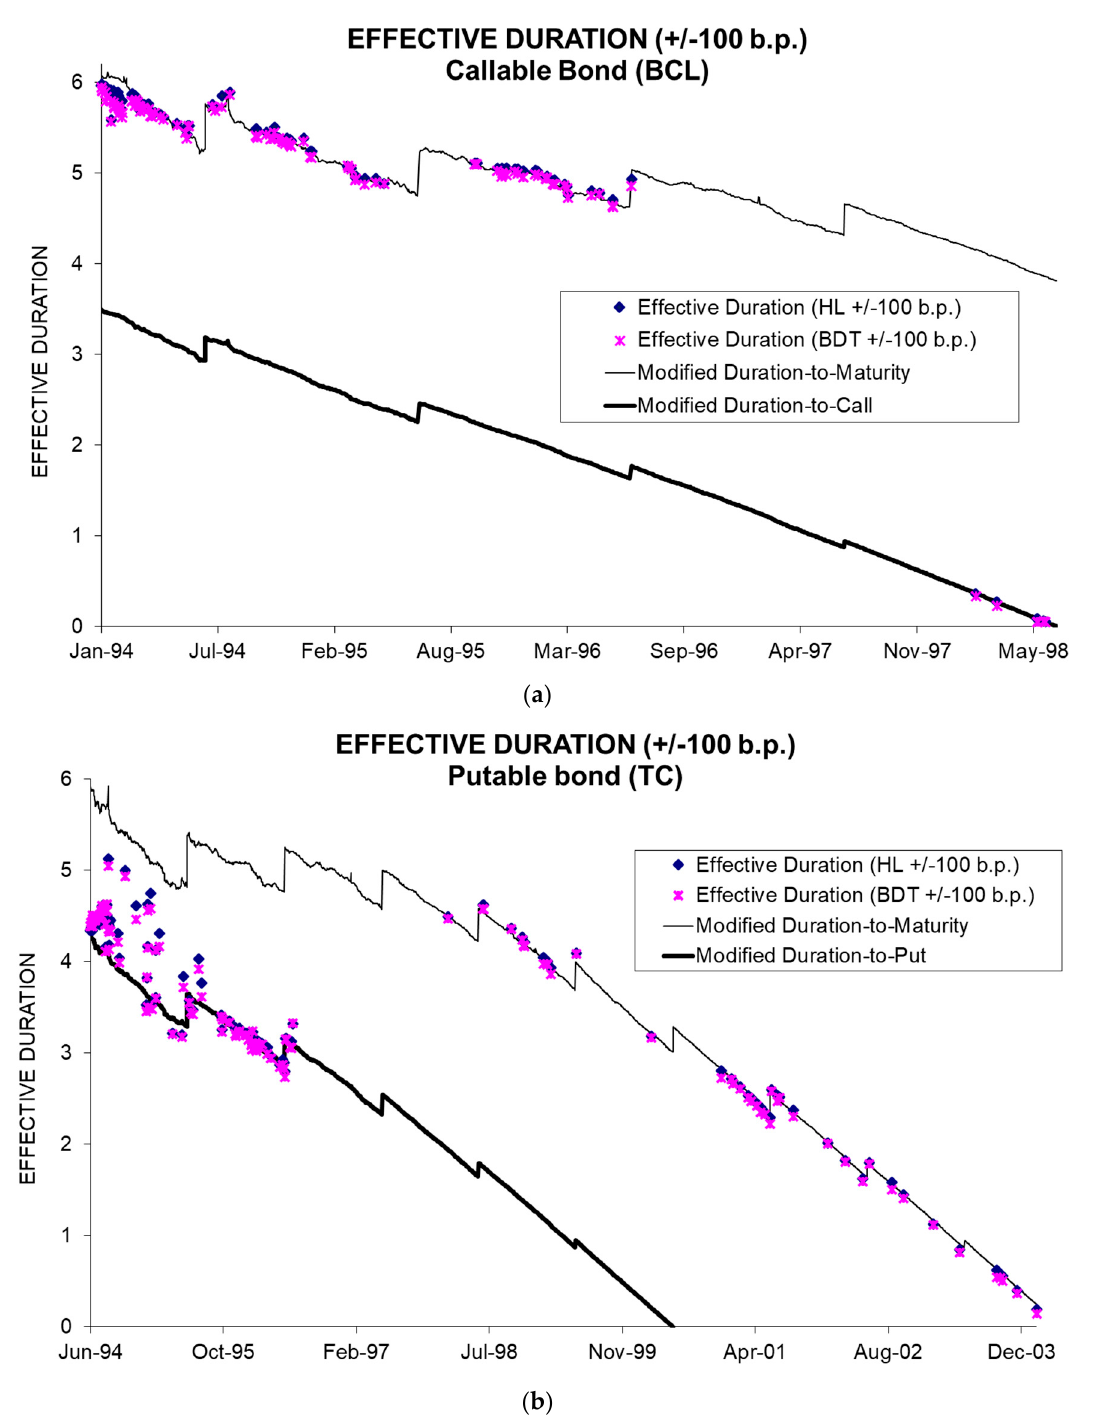
Figure 1. Evolution of the effective duration (ED) estimated from the Ho and Lee (HL) model and the Black, Derman, and Toy (BDT) model. Upper and lower black lines are the modified duration (MD)-to-maturity and the MD-to-option. Both lines limit the possible values of the ED according to the expectation of exercising the option. ( a ) shows the results for the Callable bond (BCL) and ( b ) for the Putable bond (TC).